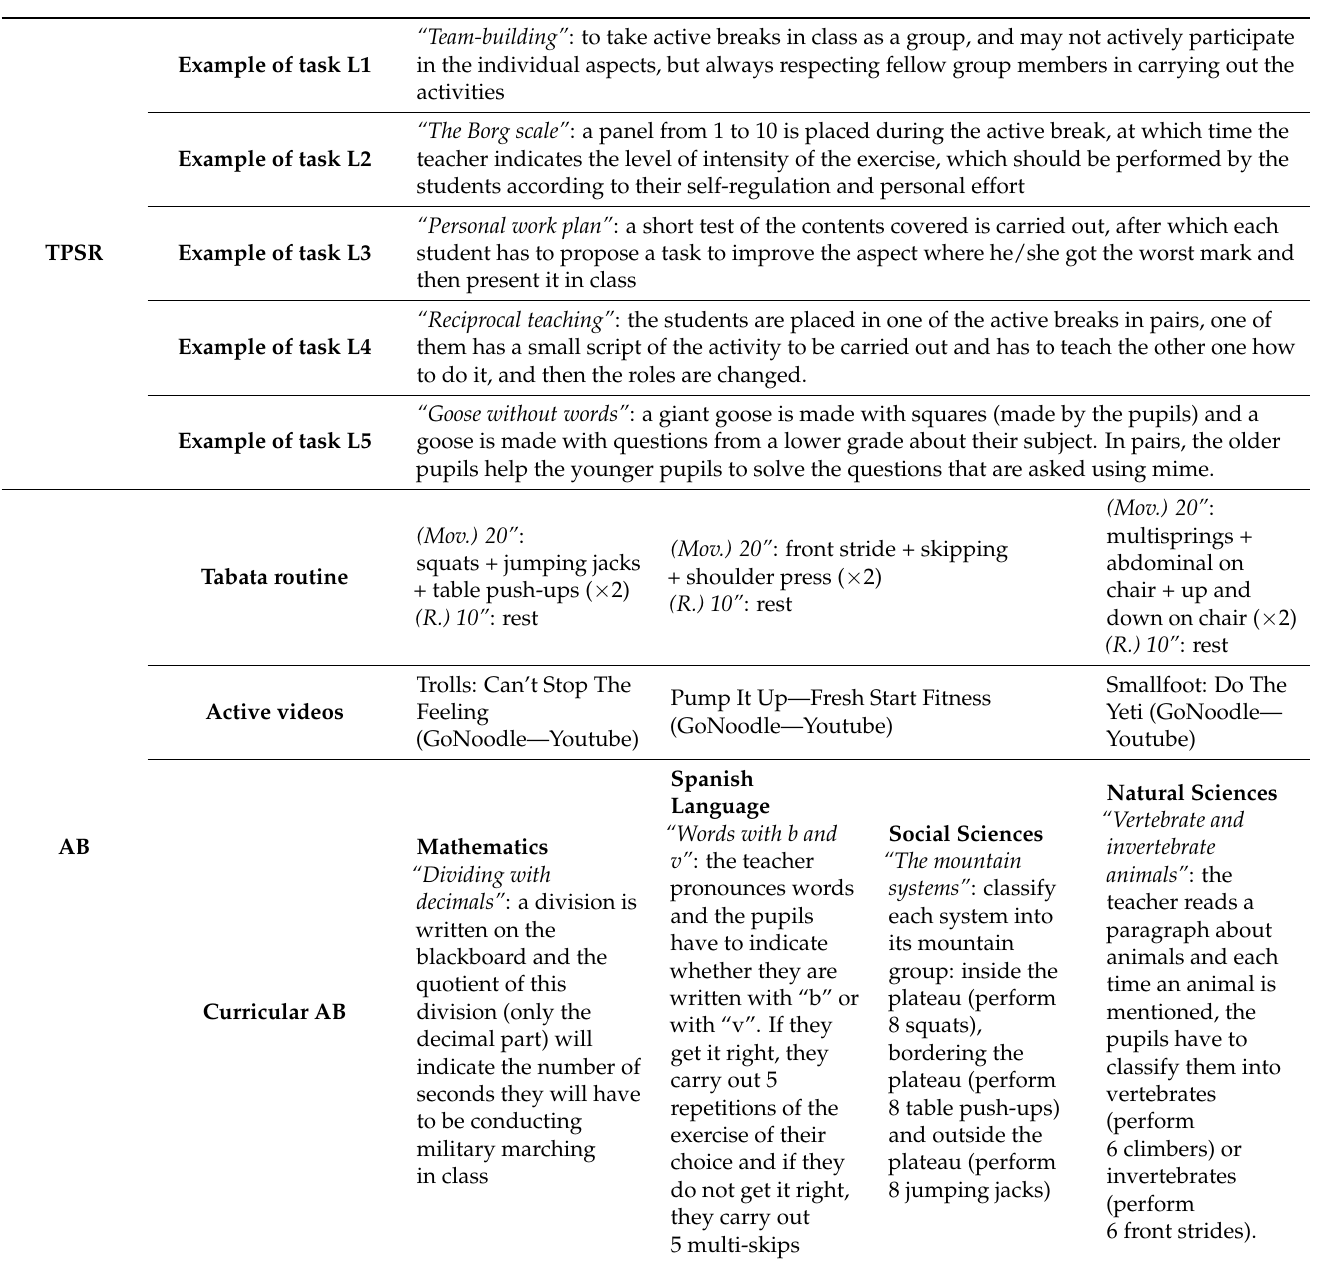
Table 3. Example of TPSR and AB tasks carried out during programme